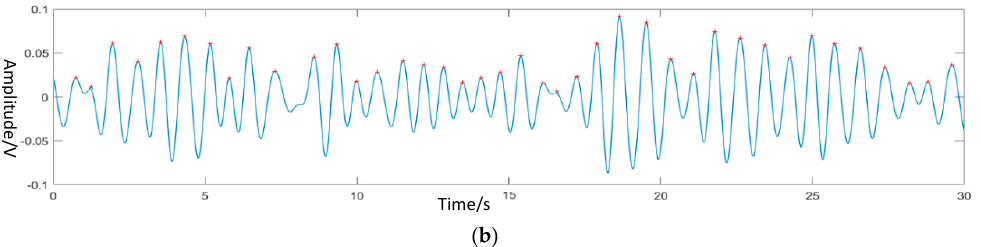
Figure 7. Heartbeat signal. ( a ) The original signal of the pulse sensor. ( b ) Reconstructed body movement signal caused by heartbeat.